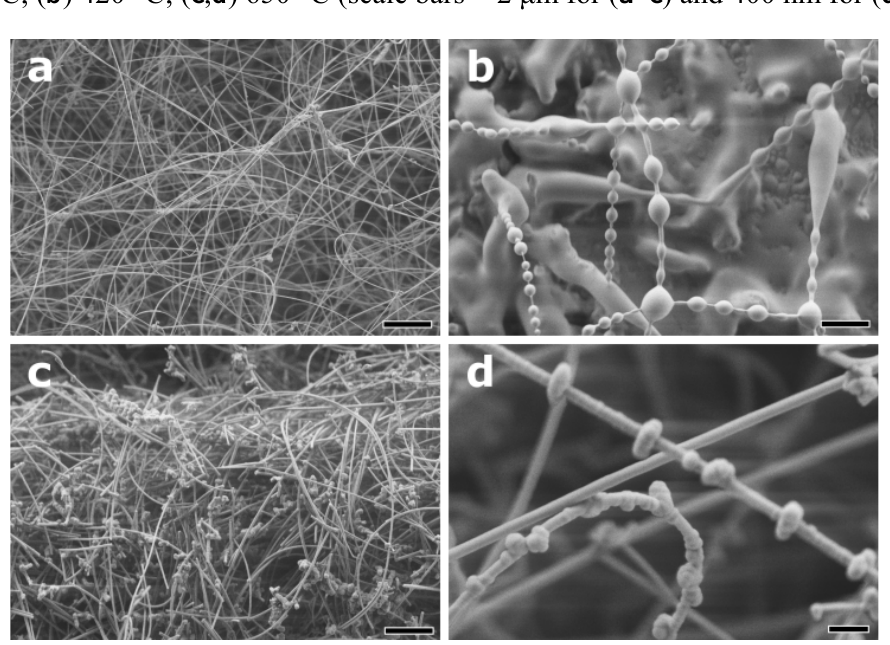
Figure 7 . Representative SEM images of nanowires grown from InP/Zn sources at ( a ) 400 °C; ( b ) 420 °C; ( c , d ) 650 °C (scale bars = 2 μ m for ( a – c ) and 400 nm for ( d)